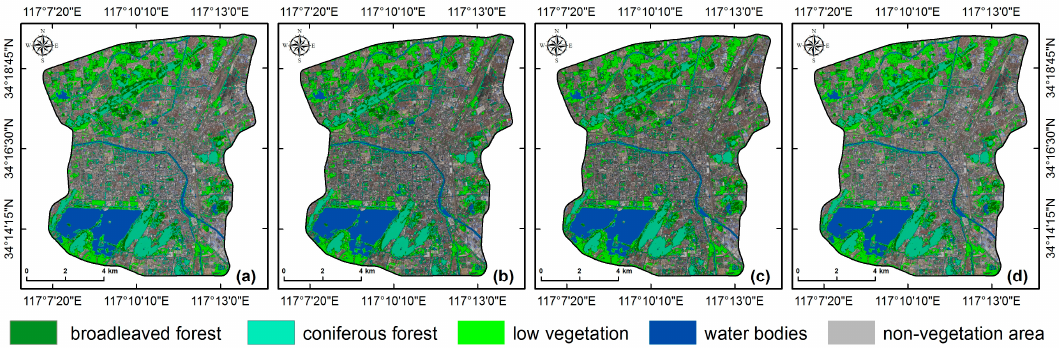
Figure 6. Land-cover maps produced from the four SVM classification models: ( a ) M1 (SF); ( b ) M2 (SF + DEM); ( c ) M3 (SF + DEM + TF); ( d ) M4 (SF + DEM + TF + VA). Table 4. Accuracy assessment of the four support vector machine (SVM) classification models using the validation data acquired from fieldwork.